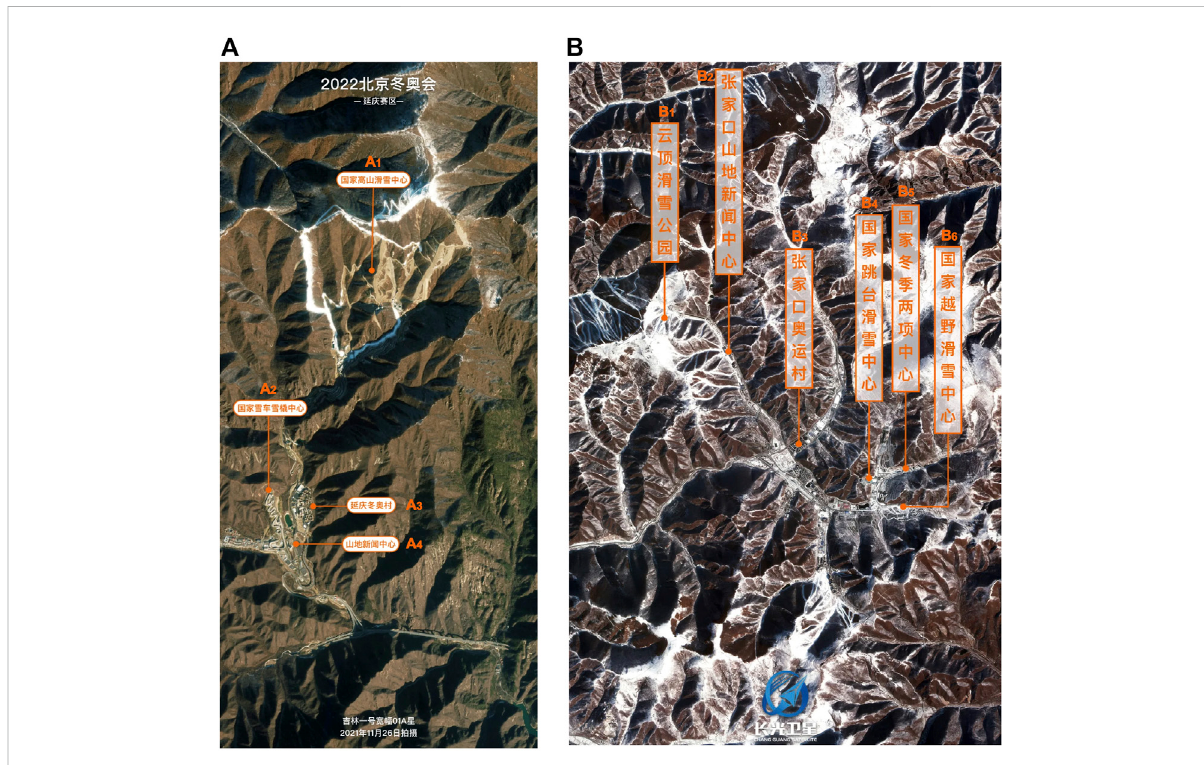
FIGURE 2 Satellite images of the Beijing 2022 Winter Olympics venues. (A) Yanqing zone: A1, Yanqing National Alpine Skiing Centre; A2, Yanqing National Sliding Centre; A3, Yanqing Olympic/Paralympic Village; A4, Yanqing Mountain Press Center; (B) Zhangjiakou zone: B1, Zhangjiakou Genting Snow Park; B2, Zhangjiakou Mountain Press Center; B3, Zhangjiakou Olympic/Paralympic Village; B4, Zhangjiakou National Ski Jumping Centre; B5, Zhangjiakou National Biathlon Centre; B6. Zhangjiakou National Cross-Country Skiing Centre. The photos were openly available from the